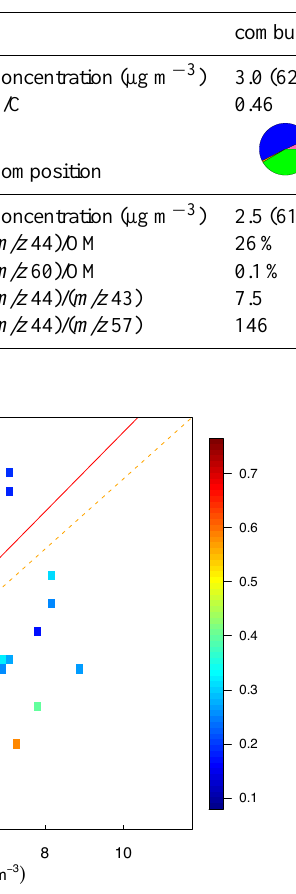
Fig. 3. Comparison of OM measured by the FTIR and the AMS. Fig. 3. See list of figure captions. Colors indicate sulfate mass fraction of PM AMS . Correlation co- efficients for high sulfate mass samples (mass fraction > 20%) and low sulfate mass samples (sulfate fraction < 20%) are 0.8 and 0.6,